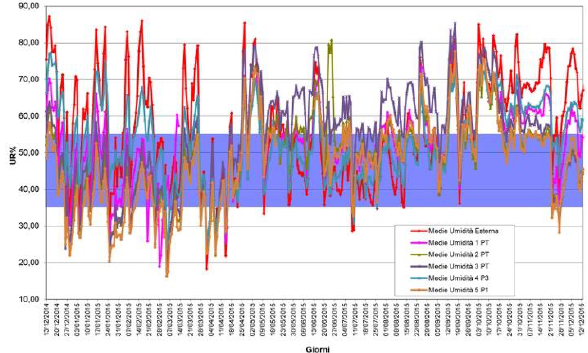
Figure 6. Relative Humidity graph. Monitoring period